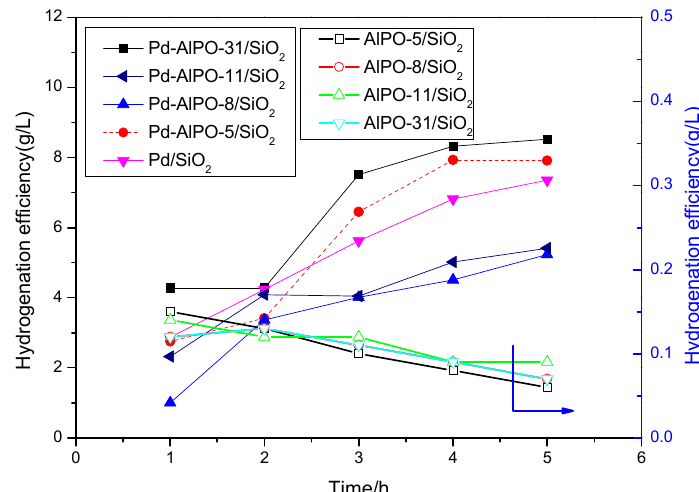
Figure 10. Catalytic activity of all samples.